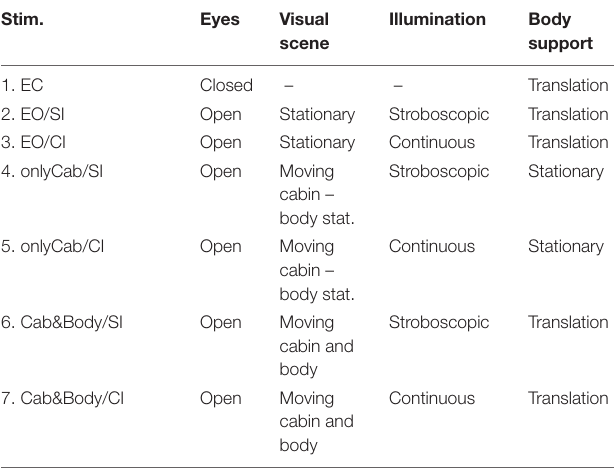
TABLE 1 | The visual and translation stimulus conditions tested (EO, eyes open; EC, eyes closed; onlyCab, only cabin with interior scene is translated, body support is stationary; Cab&Body, en-bloc translation of cabin with scene and body support; details in text).